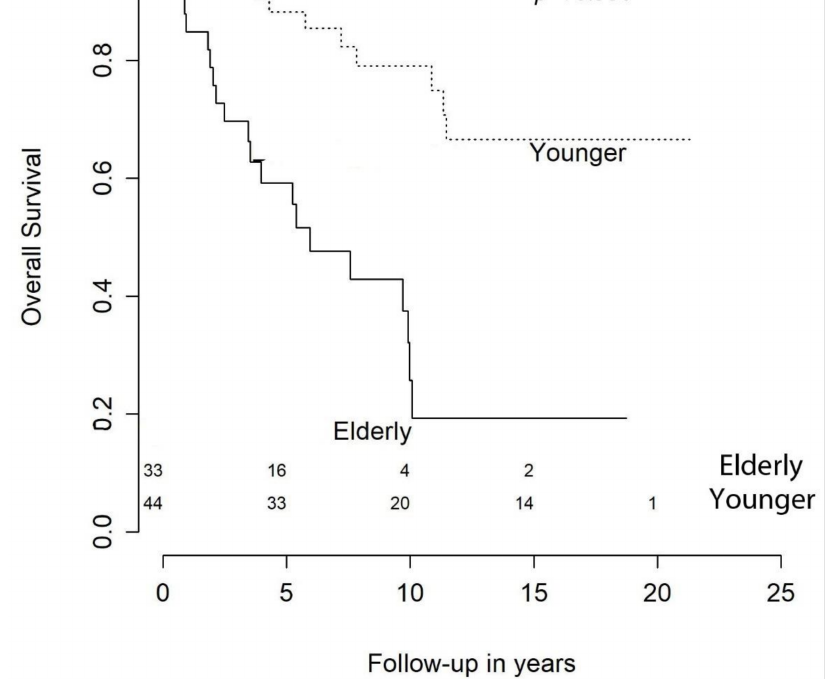
Figure 1. Overall survival by age.